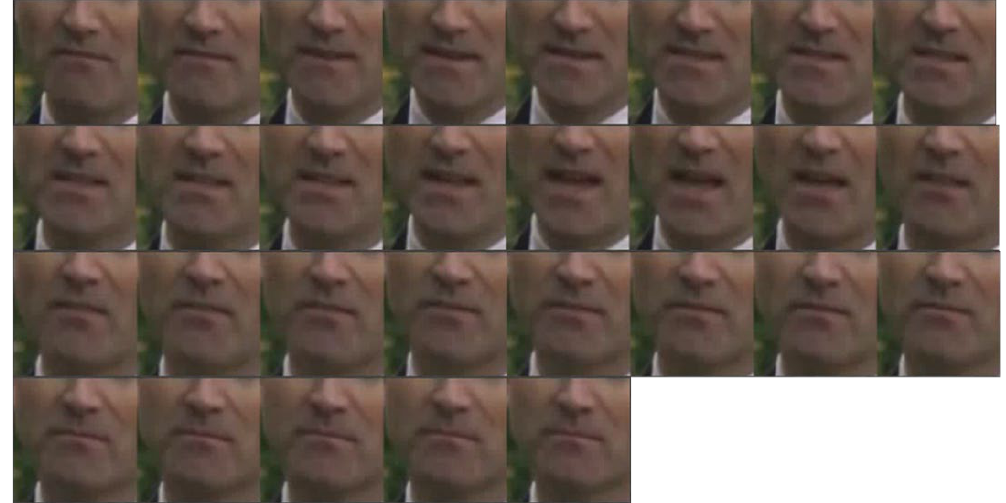
Figure 4. A sample of “DEATH” in LRW. It can be observed that the range of obvious changes in lip motion is from frame 3 to frame 16. From frame 17 on, the change in the speaker’s lip shape is not obvious.